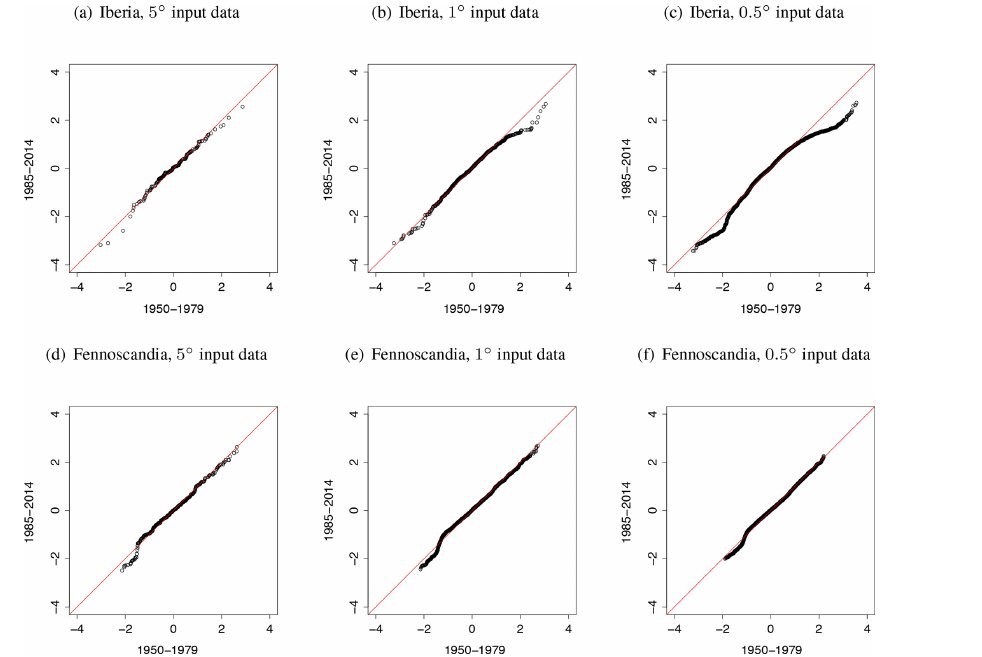
Figure 9. Quantiles of standardized temperature anomaly residuals for the different data resolutions in Iberia (a, b, c) and Fennoscandia (d, e, f) . Quantiles from the first 30 years of the data period are shown along the x axis, and quantities from the last 30 years are along the y axis. Plots are shown for 5 ◦ data (a, d) , 1 ◦ data (b, e) , and 0.5 ◦ data (c, f) .